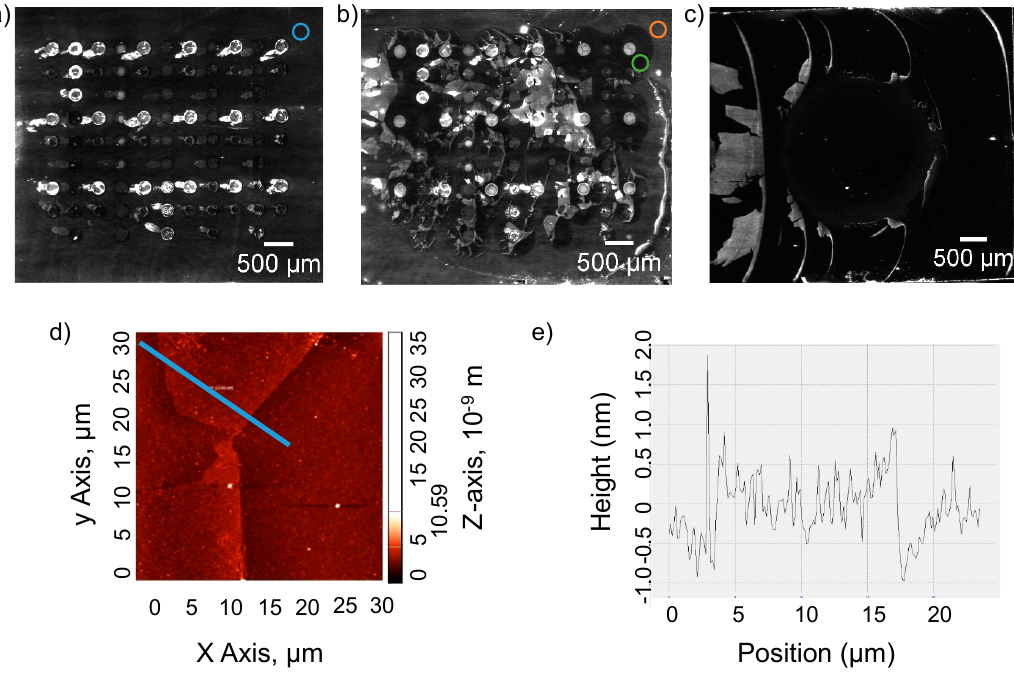
Figure 2. Characterization of the biotin–SA surface degradation after drying, probe deposition, and rewetting. Chips were either dried by a stream of nitrogen gas ( a ) or dried on the benchtop ( b–d ) after growth of the biotin–SA surface and prior to probe deposition in a humidified chamber. Chips were incubated in the chamber for 30 minutes after deposition, followed by incubation in target detection solutions ( a,b,d ) or 5 minutes in AWB ( c ), rinsed with Nanopure TM water, and dried via a stream of N 2 prior to imaging. Panels ( a–c ) are arrayed imaging reflectometry (AIR) images, while panels ( d ) and ( e ) are the result of analysis by atomic force microscopy (AFM). The array probe morphology was undesirable on chips where the B–SA surface had been dried under a stream of N 2 ( a ). The surface appears to peel away around each probe in the array (250–350 pL droplets) ( b ). The median intensity of the chip surface within the colored circles was measured with Image J; Blue: 8314, Orange: 16942, Green: 6837 ( a,b ). The peeling phenomenon scales with the size of the deposited probe (1 µL droplet, pipetted by hand) ( c ). Morphological analysis by AFM suggests a peeled layer folded over on itself ( d,e ). Other studies have reported evidence that proteins become denatured or partially unfolded